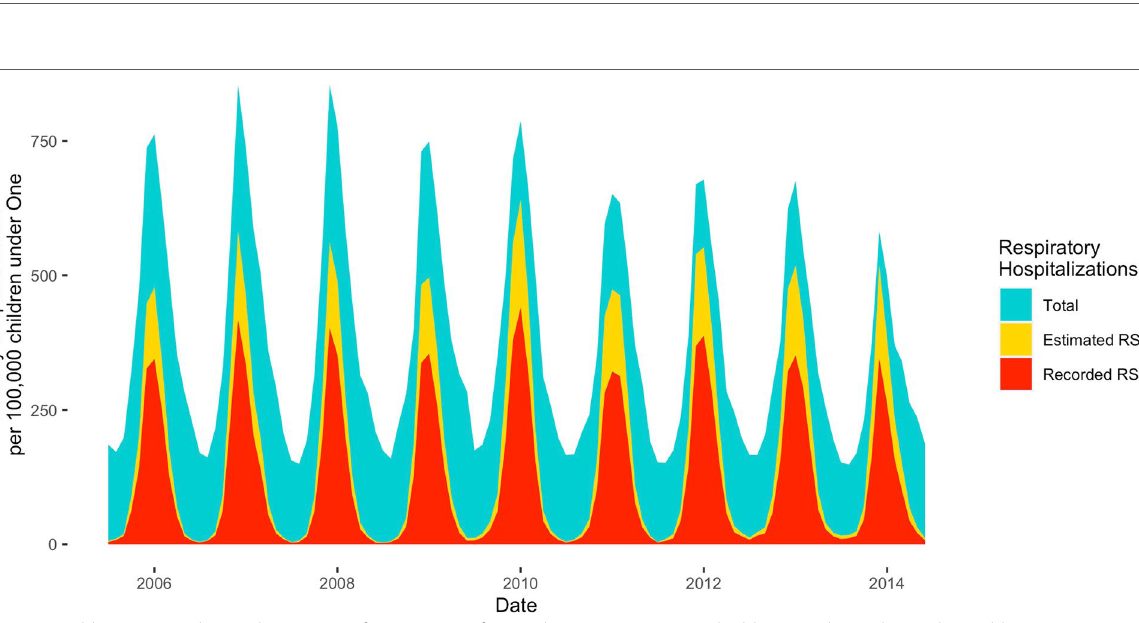
Fig. 4 Monthly respiratory hospitalizations in infants < 1 year of age, July 2005—June 2014. The blue area shows the total monthly respiratory hospitalization rate in infants < 1 year of age; the yellow area shows the estimated monthly RSV-associated respiratory hospitalizations in the same age group and the red area shows the hospitalizations recorded as being due to RSV per